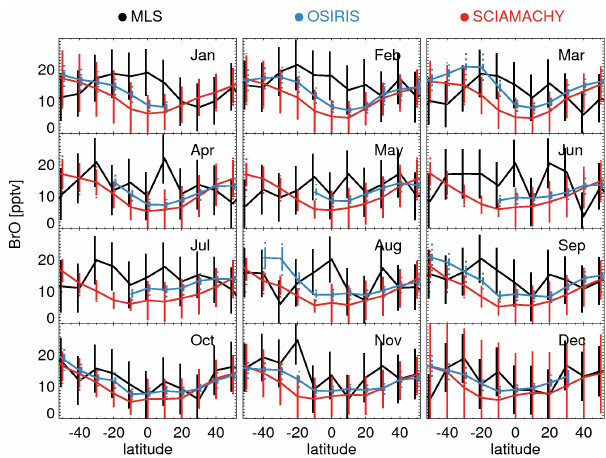
Fig. 11. Comparison between MLS (Asc − Des), OSIRIS and SCIAMACHY BrO observations at 10hPa, for 2005. The OSIRIS and SCIAMACHY means have been scaled to the local time of the MLS observations. The MLS errors represents a combination of precision and accuracy, the OSIRIS and SCIAMACHY error represent precision (solid) and precision plus scaling uncertainty (dashed). The large SCIAMACHY error bars in December are due to the few number of days available for this particular